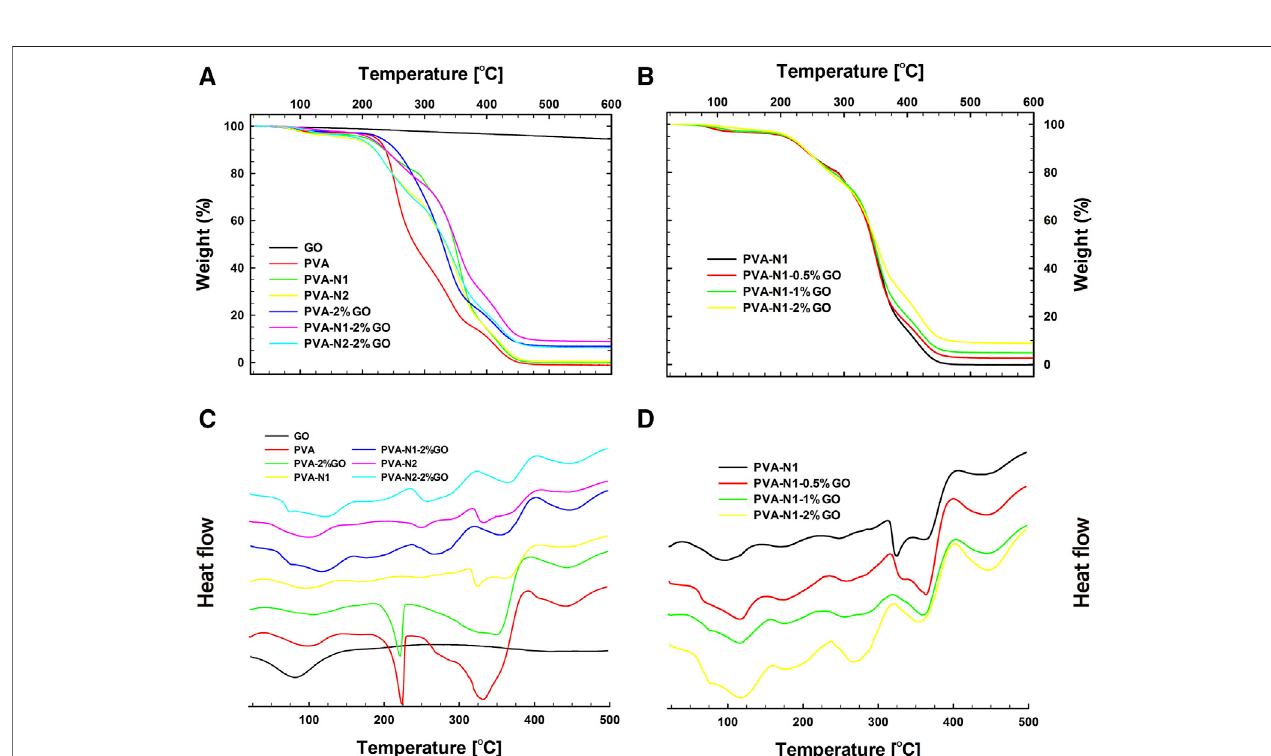
FIGURE6| ThermalbehaviorsofPVA,PVA-N,andtheirnanocomposites.TGA (A) andDSC (C) resultsofGO,PVA,PVA-N1,PVA-N2,PVA-2%GO,PVA-N1-2%, and PVA-N2-2%GO, and TGA (B) and DSC (D) results of PVA-N1 and its nanocomposites: PVA-N1-0.5%GO, PVA-N1-1%GO, and PVA-N1-2%GO.